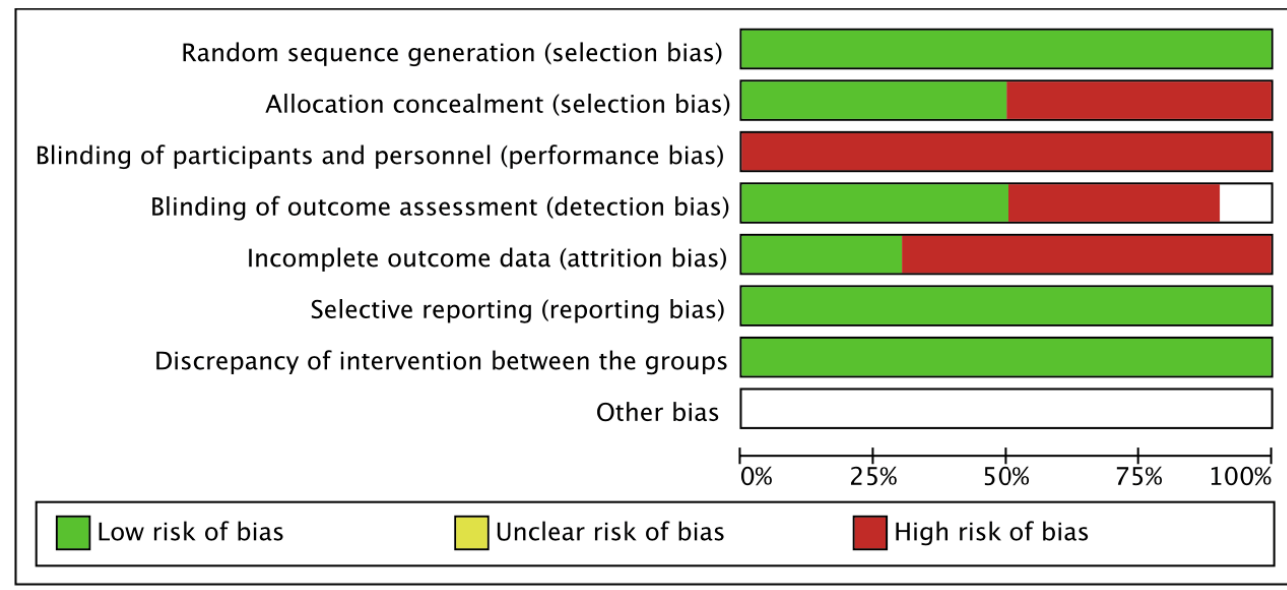
Figure 2. Details of risk of bias among the included studies.